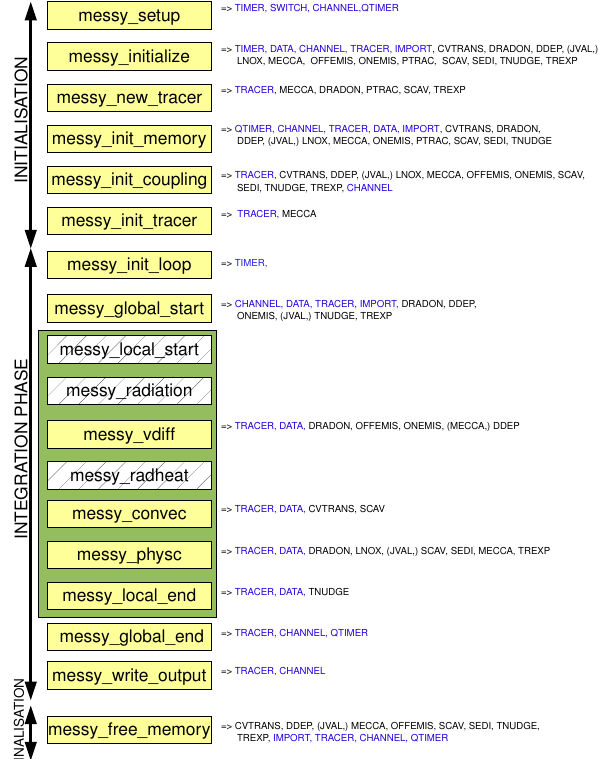
Fig. 2. List of all entry points available in ECHAM5/MESSy. The entry points highlighted with yellow boxes are currently imple- mented in COSMO/MESSy, the hatched ones are not yet required, as the dependent submodels are not used in COSMO/MESSy so far. Next to the boxes the generic (blue) and regular (black) submodels currently called in COSMO/MESSy by the respective CONTROL subroutine are listed. The green box surrounds those entry points located in the outer loop over the second horizontal dimension in ECHAM5/MESSy.